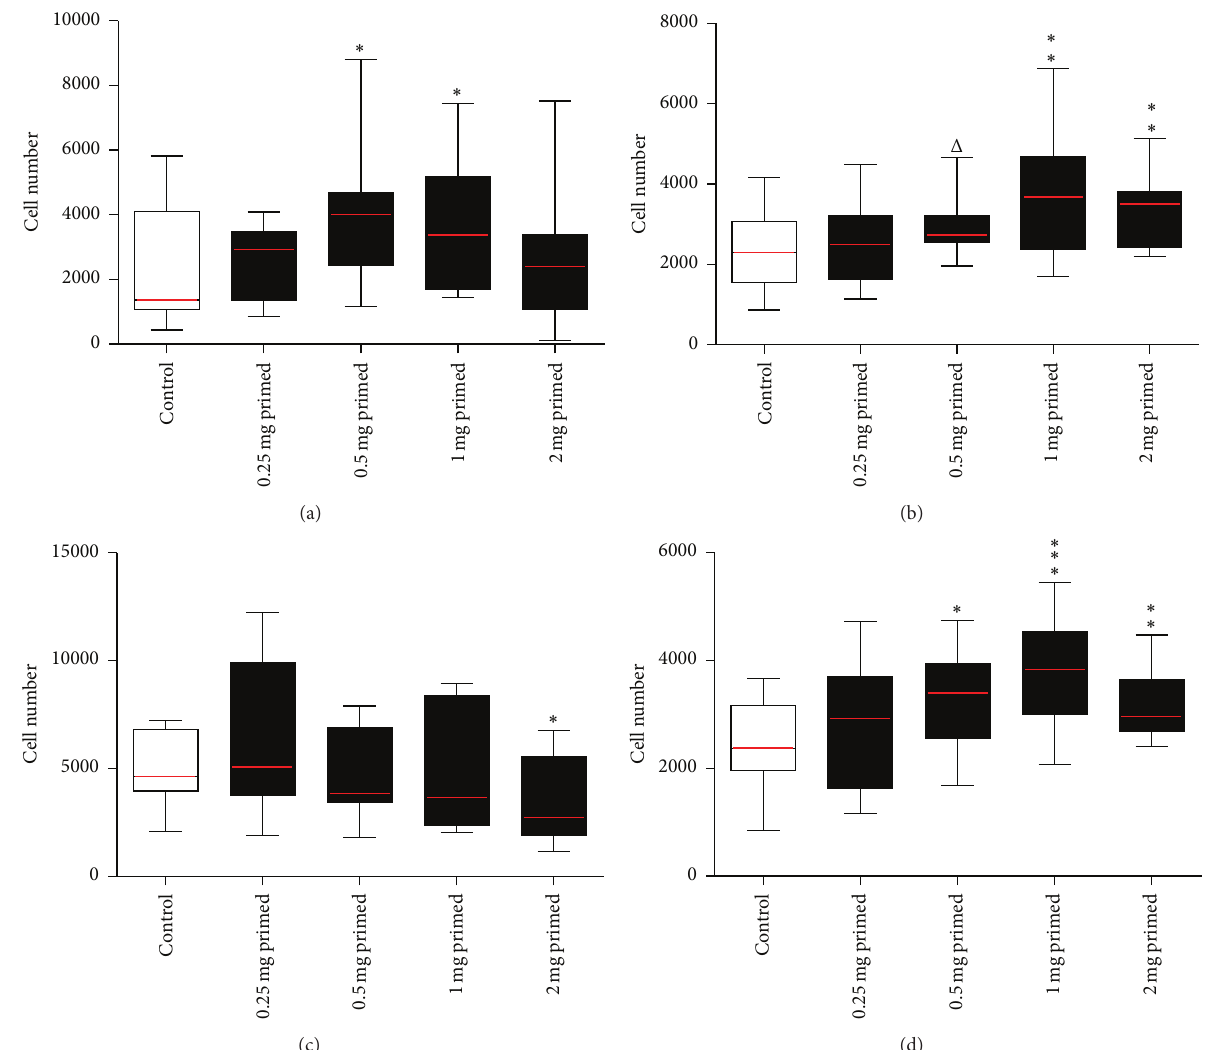
Figure 2: MSCs grown in HA media and seeded in control media (primed). MSCs expanded until passage 2 in control media. Cells were then stripped and cell suspensions were counted using the standard enumeration technique. Cells grown control media, flask (A), were seeded in control media (control) ( − − ) and MSCs grown in flasks (B–E) HA media were seeded into 96-well plates in control media (HA primed) (+ − ), to make up the five conditions ( 𝑥 -axis). Conditions were tested using five technical replicates per 96-well plate and run in biological triplicate ( 𝑛 = 3 ). Wells were assayed at the endpoint using Cell Counting Kit-8 with standard curves run on every 96-well plate seeded 24 hours prior to endpoint and absorbance read at a wavelength of 450 nm ( 𝑦 -axis). All conditions were compared back to the control using a 𝑡 -test ( Δ 𝑝 value = 0.1, ∗ 𝑝 value < 0.05, ∗∗ 𝑝 value < 0.01, and ∗∗∗ 𝑝 value < 0.001). (a) MSCs seeded in standard 96-well plates for 24 hours (adherence), (b) MSCs seeded in standard 96-well plates for three days (proliferation), (c) MSCs seeded in high -adherence 96-well plates